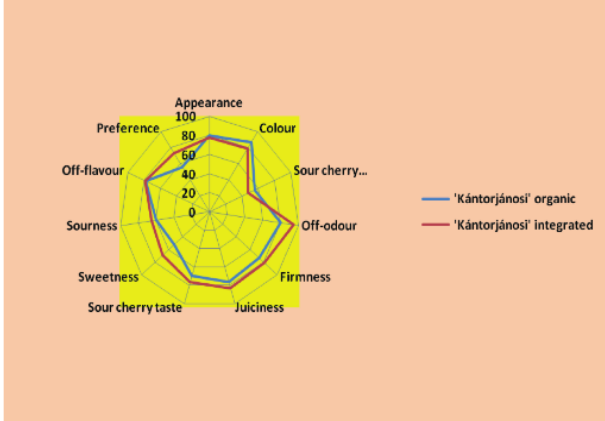
Figure 2: Principal component analysis, loading plot of sour cherry data